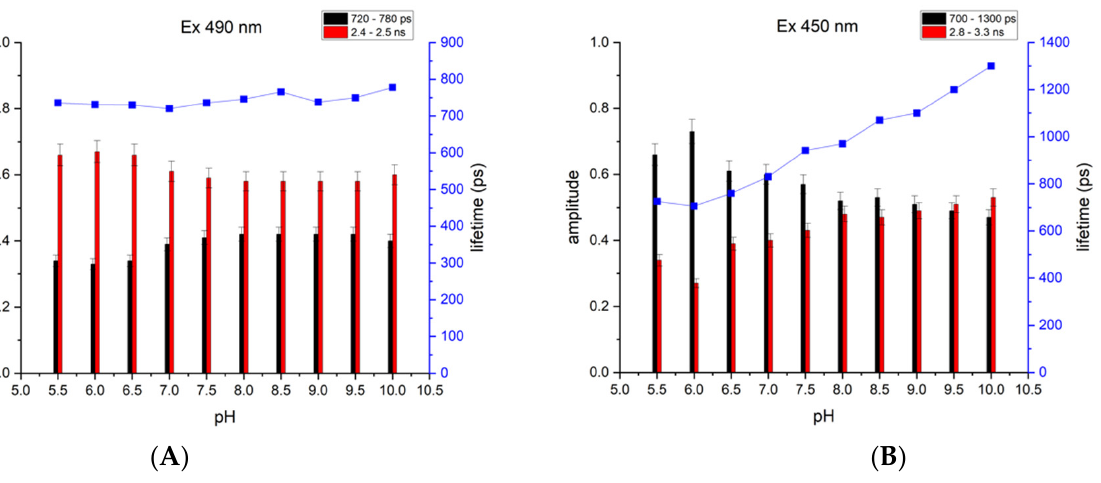
Figure 1. Relative contributions (relative amplitude, left vertical axis) and lifetimes (the value of the short-lived component is shown as blue squares, right vertical axis) of both components based on the biexponential fit of the fluorescence decay data of EGFP-Y145L/S205V upon excitation with ( A ) a 490 nm, single-photon laser source and ( B ) a 450 nm, single-photon laser source at different pH levels varying from pH = 5.5 to pH = 10.0. The black columns denote the contribution of the short-lived component, and the red columns denote the long-lived component. The blue squares and the solid line (right axis) show the lifetime of the short-lived component.